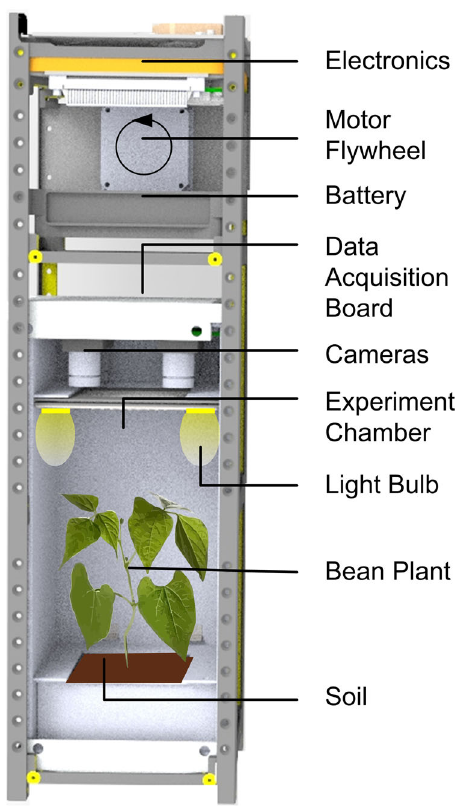
Fig. 4 Conceptual adaptation of the 3U design, utilizing similar software and hardware, for biology and life-science experiments on board the ISS. Onboard are electronics for spin control, camera imaging, thermal and atmospheric sensing, environment control, and data acquisition. Here the lab chamber features a small plant growing under arti fi cial light and gravity, with soil maintained at set point moisture. Illustration by A. Chandra and J.